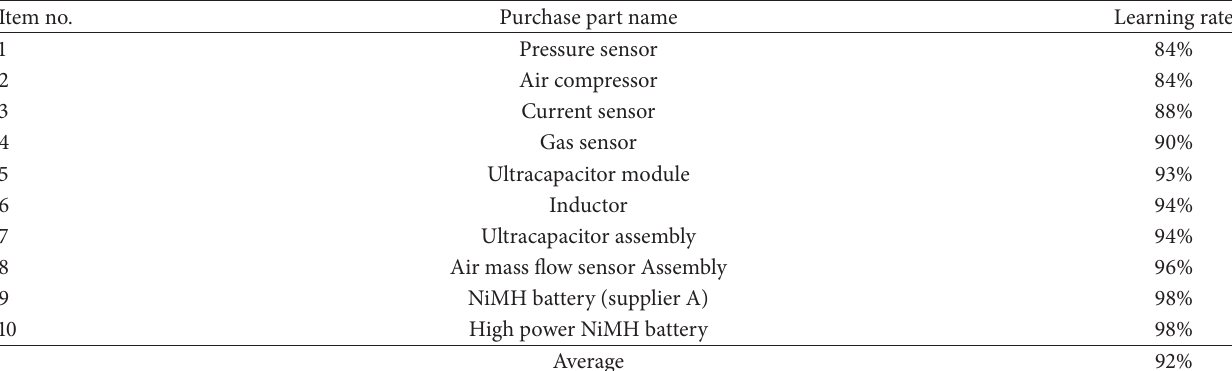
Table 2: Learning rate of parts with no plateau.